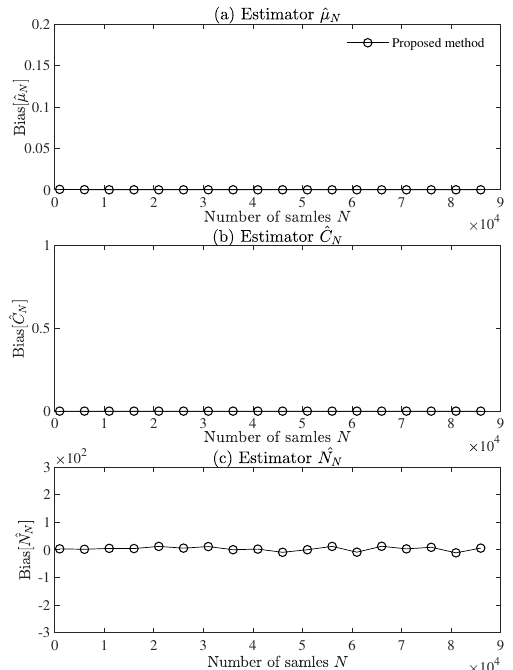
Figure 5. Bias errors for various numbers N of samples in the proposed